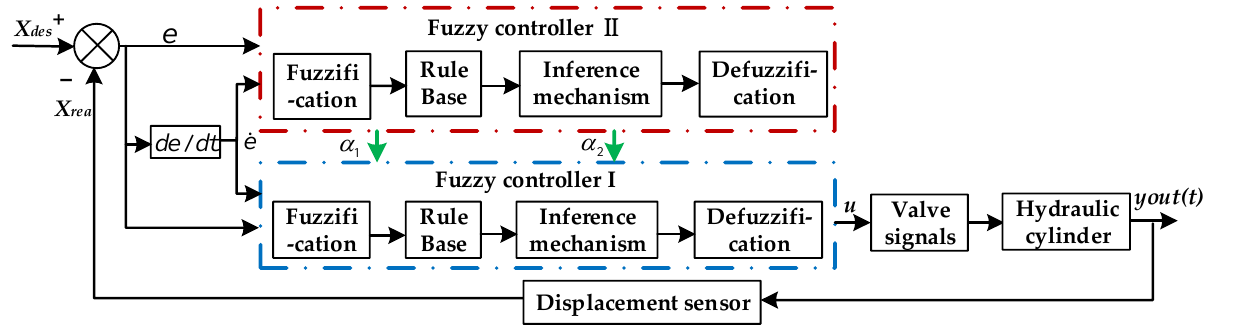
Figure 6. Block diagram of the variable universe fuzzy controller.